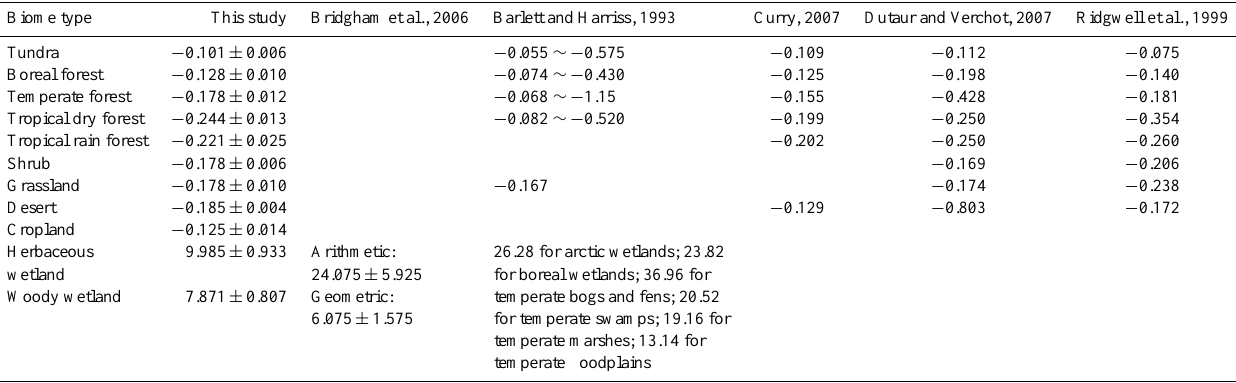
Table 8. Comparison of the DLEM-estimated CH 4 emission rate (gCm − 2 a − 1 ) with other studies at biome level (Positive values represent CH 4 emission, and negative values represent CH 4 uptake).